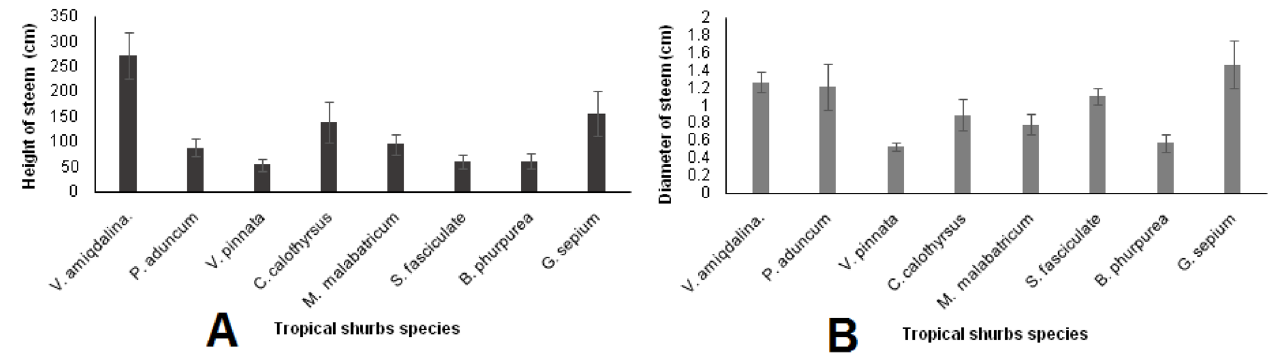
Figure 2. ( A ) Height and ( B ) diameter comparison of tropical shrub stems 5 months after planting measured from all fertilizer